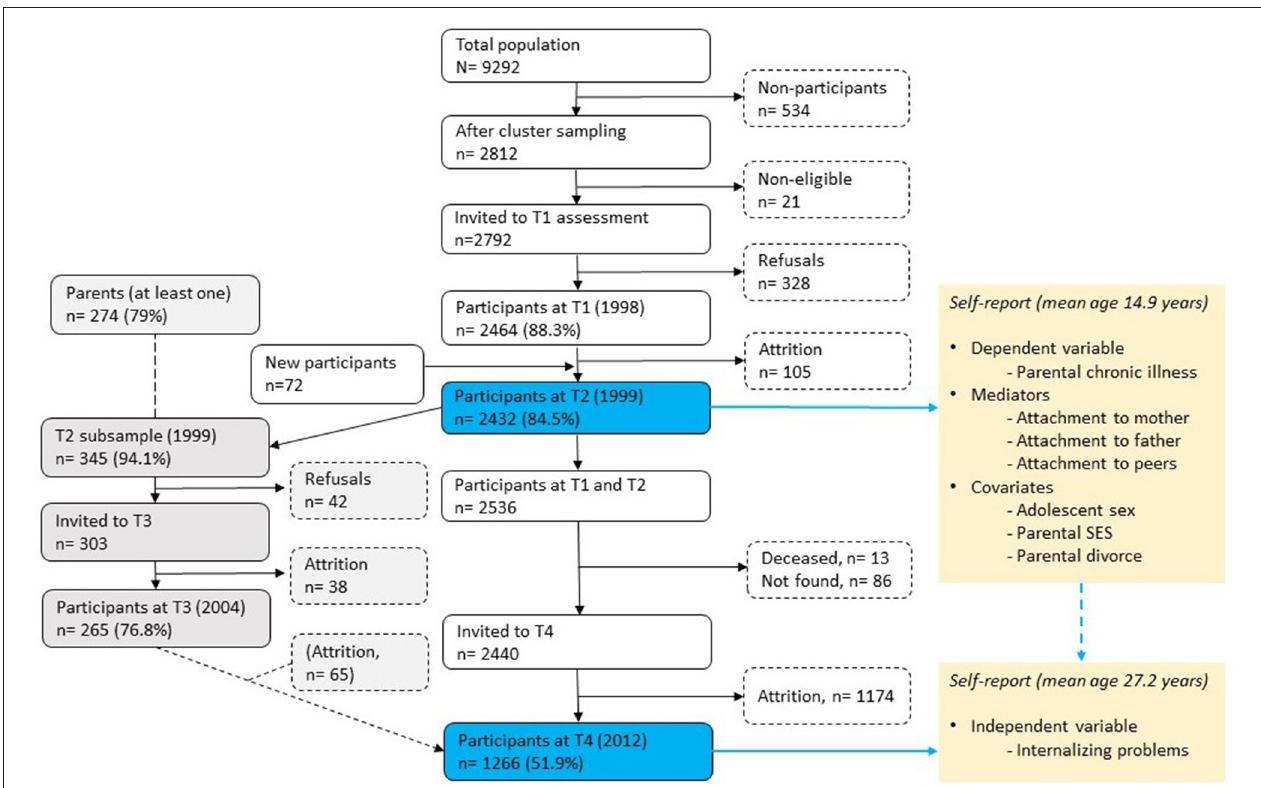
FIGURE 1 | Procedure and flow of participants in the Youth and Mental Health Study. T1 = Time 1, T2 = Time 2, etc. The data used in the current study are highlighted by blue boxes (T2 and